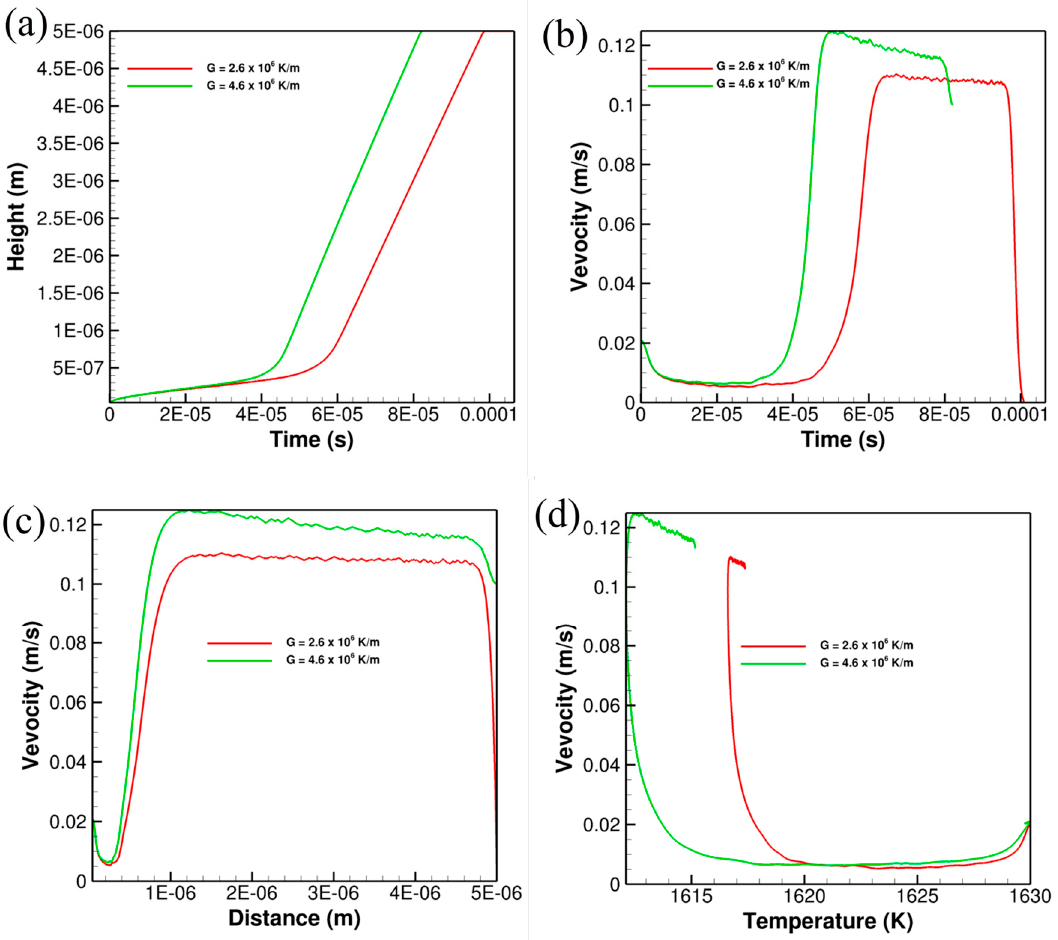
Figure 15. Dendrite growth kinetics for non-steady-state solidification with an imposed temperature gradient in the liquid an initial s-l interface temperature of 1630 K. Simulated s-l interface ( a ) position as function of time and velocity as function of time ( b ) distance ( c ) and as a function of interface temperature ( d ).